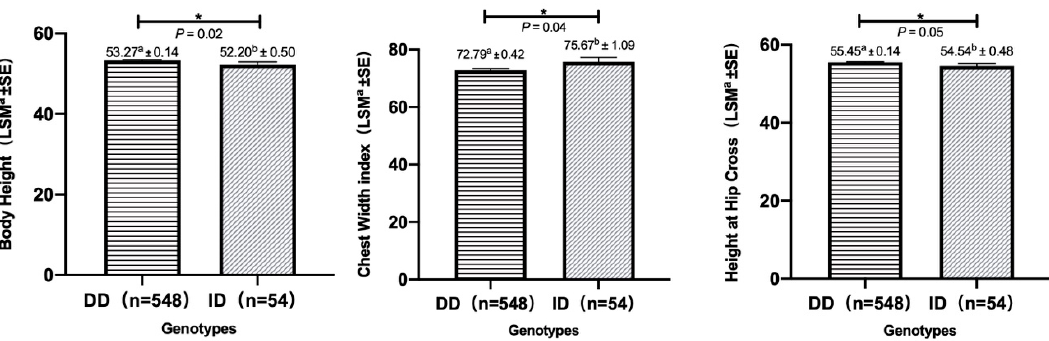
Figure 2. Association of the 5 bp indel within the MSTN gene with body height, height at hip cross, and chest width index in kids of SBWC goats.